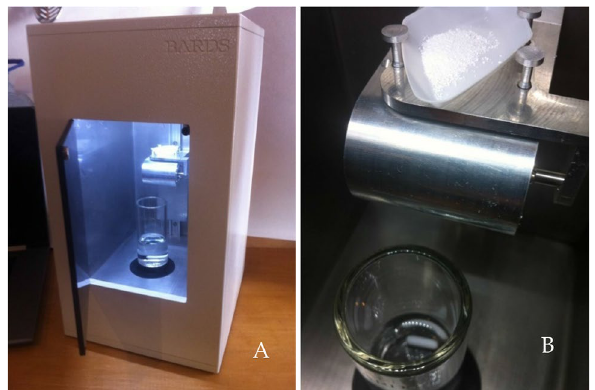
Figure 1. ( A ) External view of the BARDS instrument and ( B ) Tipper motor with a powder sample in a weighing boat ready for addition to the stirred solution below 27 .